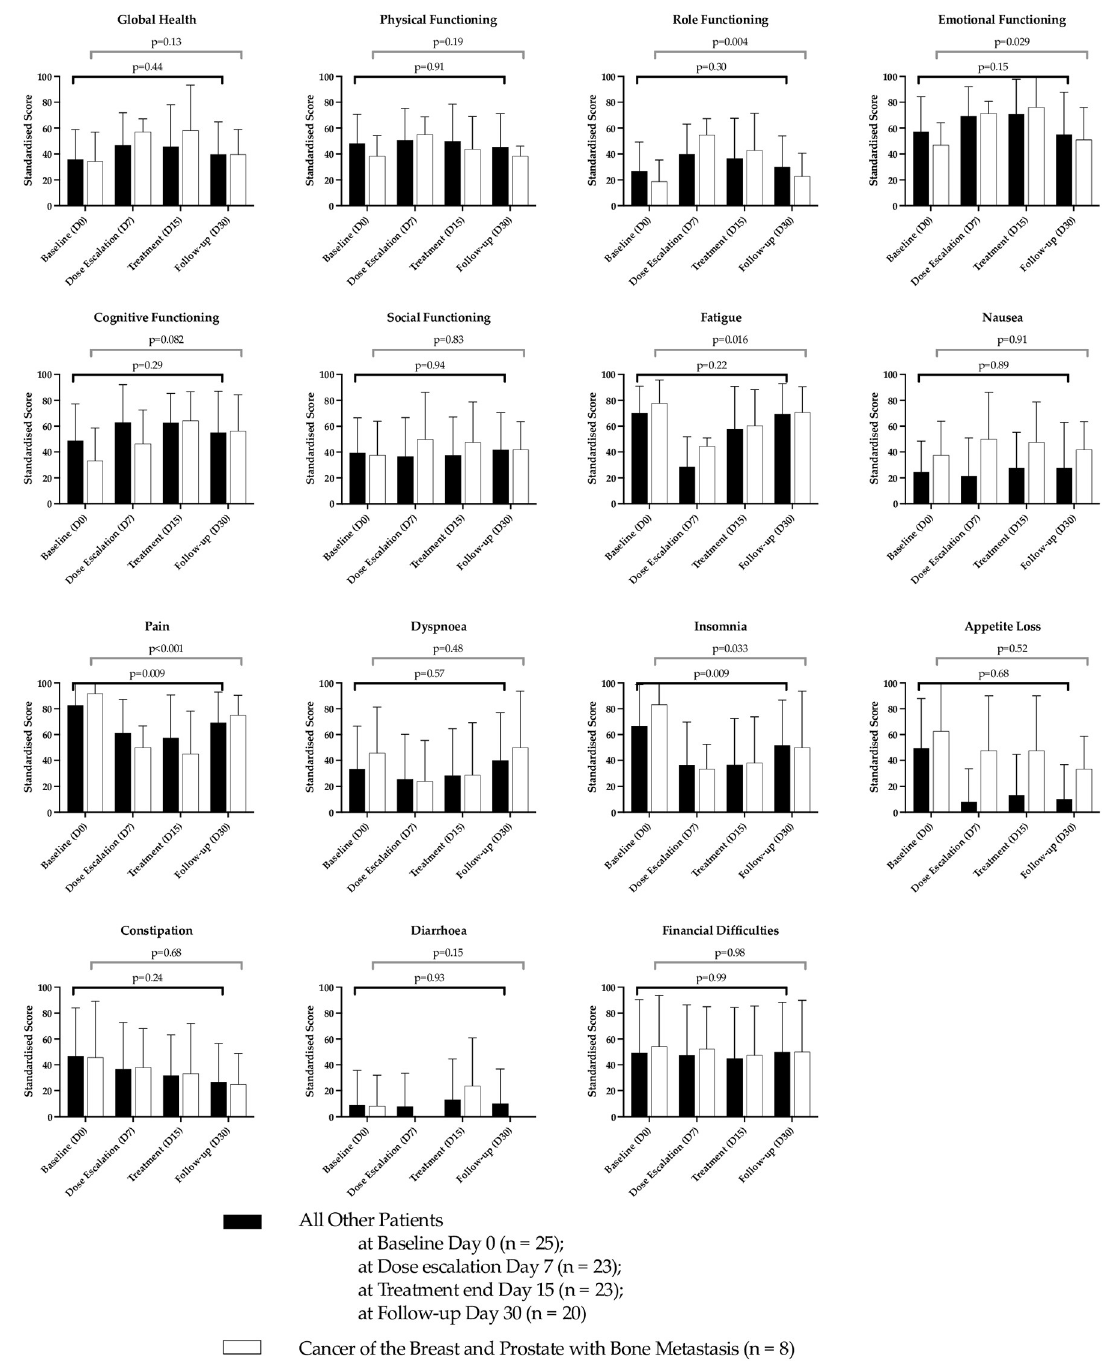
Fig 2. EORTC-QLQ-30 scores relevant to improvement or deterioration of global functioning and symptoms between patients that demonstrated improvement in pain from those patients with breast and prostate cancers and bone metastasis compared to patients from the remainder of the cohort. Error bars represent